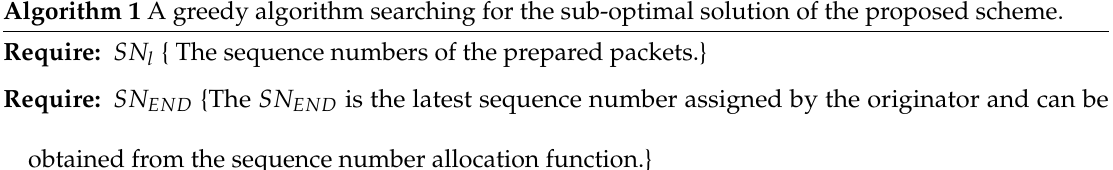
Algorithm 1 A greedy algorithm searching for the sub-optimal solution of the proposed